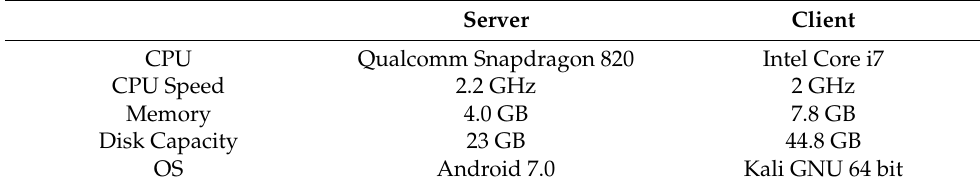
Table 1. Server and Client characteristics.